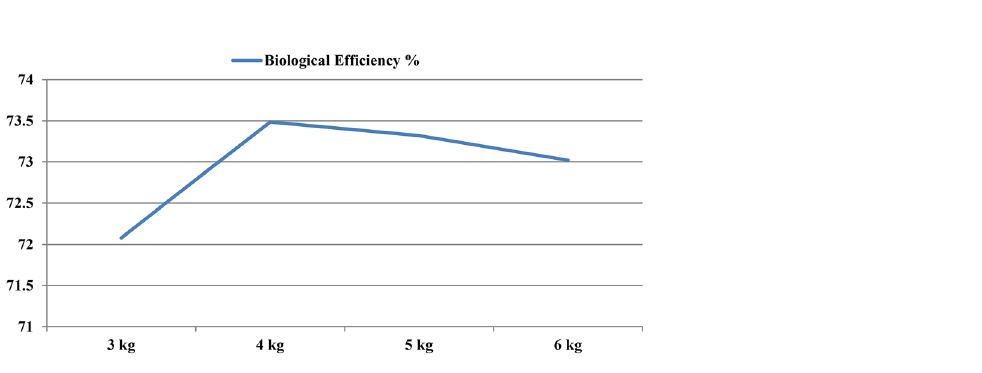
Figure 11. BE% obtained from different substrate